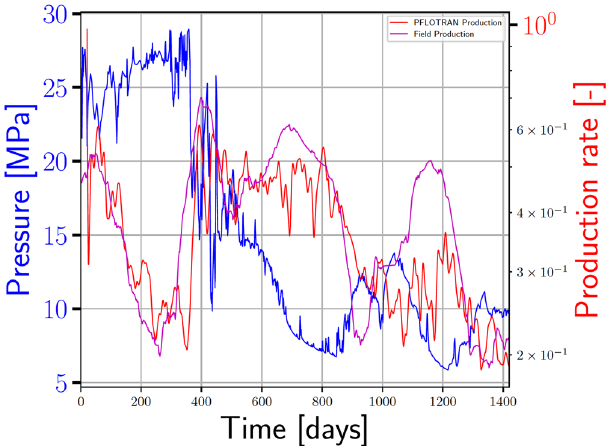
Figure 4. Benchmarking our model using actual dynamic production data from the MIP-3H well at the MSEEL site. The well boundary is assigned the same pressure as the well at the site (blue line) and we measure the amount of gas that is removed from the system. The agreement between the production from our simulated system (red line) agrees quite well with the field data (magenta line). Some differences are to be expected due to the assumptions in the model, but they do not appear to affect the first order behavior, especially for the first few years of production. At later times, the model diverges slightly, which could be due to second order effects (e.g., fracture mechanics and stimulation, interacting wells) that are not included in the